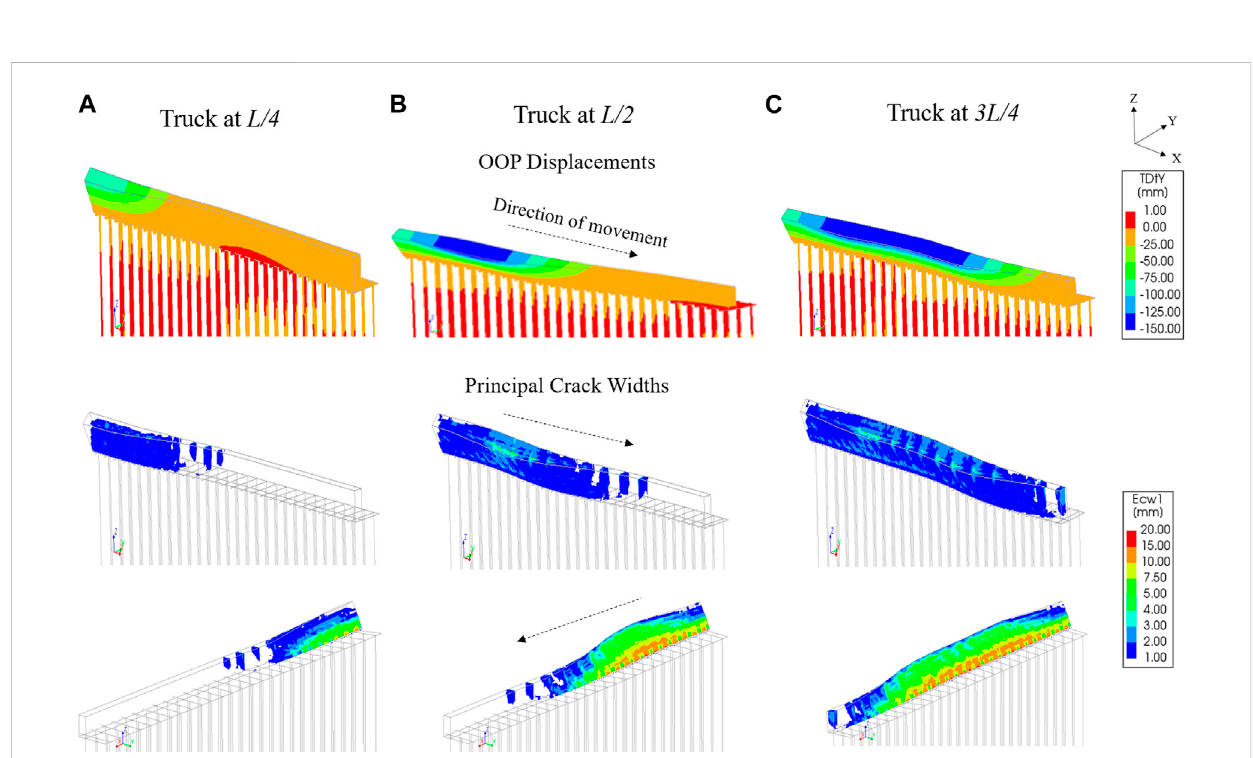
FIGURE 10 Out-of-planedisplacementsandprincipalcrackwidthsof Model1 duringthepassageofthe fi re-truck( LM =40)atdifferentinstants:truckat (A) L/4 ; (B) L/2 and (C) 3L/4 . (Deformation scale factor =